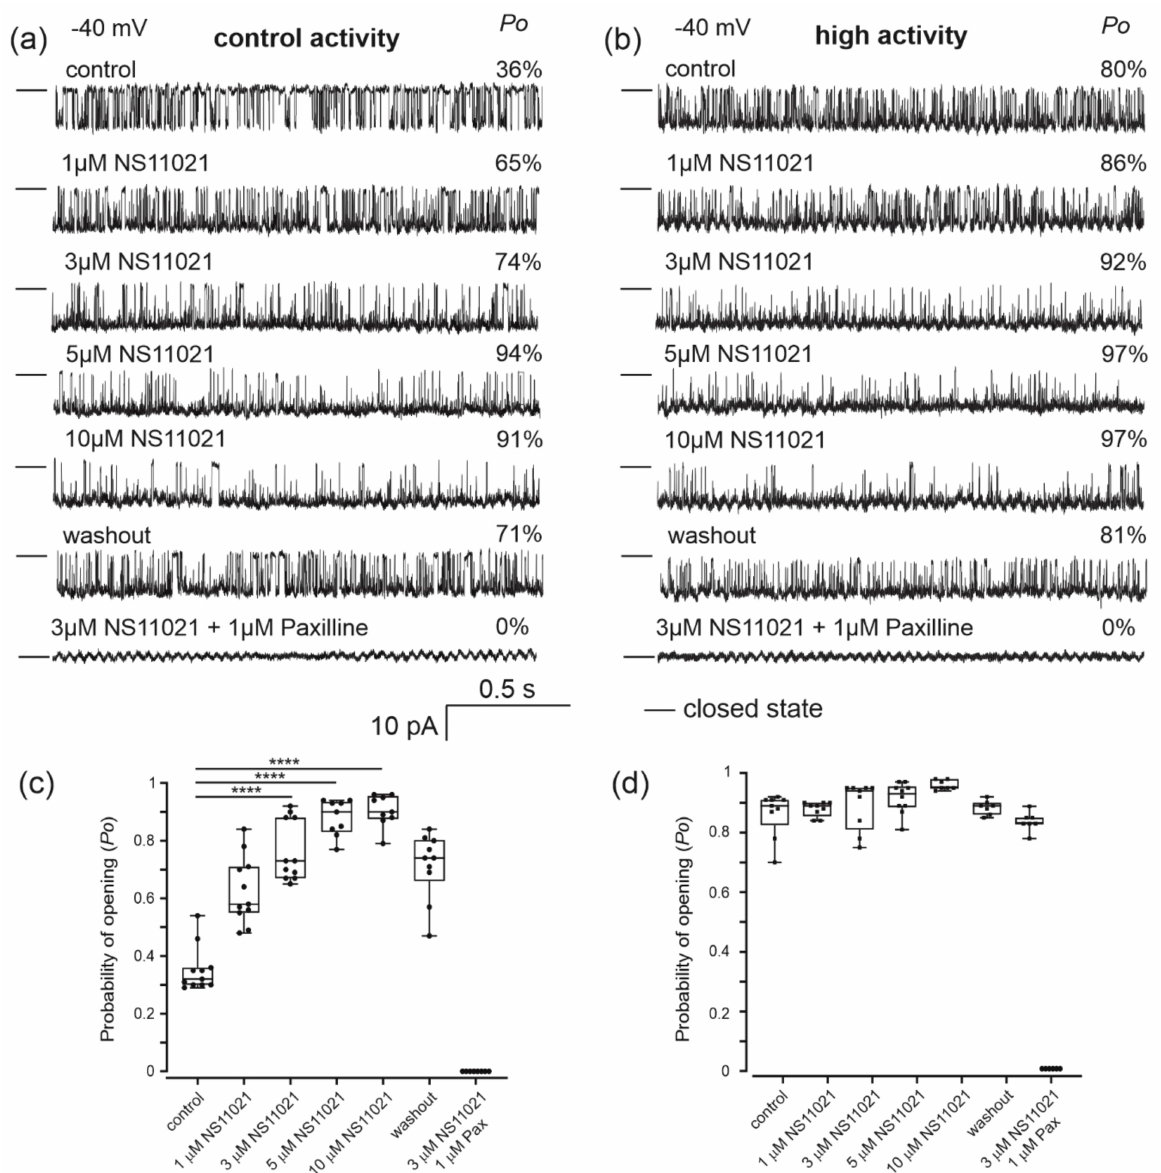
Figure 4. Effects of the potassium channel opener NS11021 on the BK Ca channel present in human bronchial epithelial mitochondria. ( a , b ) Representative traces of single-channel recordings of mitoBK Ca channels from human bronchial epithelial mitochondria in symmetric 150/150 mM KCl control solution (100 µ M Ca 2+ ) under different conditions. Sequences of the applied drugs (NS11021 and paxilline) are presented in the graph. Left panel, ( a ) mitoBK Ca channel with control activity, and right panel, ( b ) mitoBK Ca channel with high activity. Single-channel activities from different experiments ( n = 3) recorded at − 40 mV. “—” indicates a closed channel state. The Po analysis (%) of single channel events is shown. ( c , d ) Analysis of the mitoBK Ca channel open probability under different conditions: control (100 µ M Ca 2+ ), different concentrations of NS11021, washout and 3 µ M NS11021 plus 1 µ M paxilline. Left panel, ( c ) mitoBK Ca channel with control activity, and right panel, ( d ) mitoBK Ca channel with high activity. Notes: the boxes include values for Po , the dots are single counted traces, the line across the box indicates the median, and whiskers show the minimum and maximum values for Po . The data are presented as the means ± SD ( n = 3). p < 0.0001